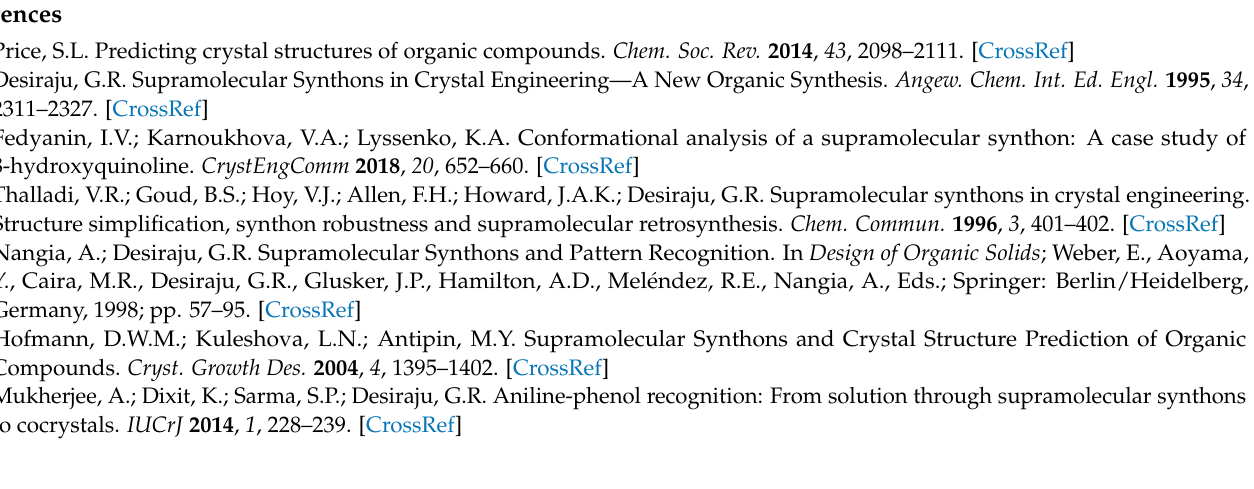
tures, 99.5%) conformations; Figure S2. (a)Propensity-coordination chart of P1 - P6 molecules and (b) coordination of each functional group in all predicted motifs; Figure S3. Propensity-coordination chart of P7 - P8 molecules and the coordination of each functional group in all predicted motifs; Figure S4. Propensity-coordination chart of P9 - P10 molecules and the coordination of each functional group in all predicted motifs; Figure S5. Propensity-coordination chart of P11-P12 molecules and the coordination of each functional group in all predicted motifs; Figure S6. 1 H NMR of 3-acetamido- 1H-pyrazole, P1 ; Figure S7. 1 H NMR of 3-acetamido-5methyl-1H-pyrazole, P2 .; Figure S8. 1 H NMR of 3-propamido-1H-pyrazole, P3 ; Figure S9 . 1 H NMR of 3-propamido-5methyl-1H-pyrazole, P4 ; Figure S10. 1H NMR spectrum of 3-butyramido pyrazole, P5 ; Figure S11. NMR spectrum of 3-butyramido 5-methyl pyrazole, P6 ; Figure S12. 1 H NMR of 3-benzamido-1H-pyrazole, P7 ; Figure S13. 1 H NMR of 3-benzamido-5methyl-1H-pyrazole, P8 ; Figure S14. 1 H NMR of N-(pyrazole- 2-yl)nicotinamide, P9 ; Figure S15. NMR spectrum of N-(5-methylpyrazol-2-yl)nicotinamide, P10 ; Figure S16. NMR spectrum of N-(pyrazole-2-yl)isonicotinamide, P11 ; Figure S17. NMR spectrum of N-(5-methylpyrazol-2-yl)isonicotinamide, P12 ; Table S1. Energies of each trans amide conformation relative to most stable trans conformation is shown below in kJ/mol. The conformations with dupli- cate energies were ignored. Note: methyl-based target molecule conformations are not shown here; Table S2. Hydrogen-bond energies (in kJ/mol) for each individual synthon for molecules P1 - P12 . Synthon A and C are dimeric synthons; therefore, energies are presented for pairs of molecules; Table S3. Hydrogen-bond energies (in kJ/mol) for each combination synthon for molecules P1 - P12 ; Table S4. Functional groups used to determine the hydrogen-bond propensities for the P1-P12 target molecules. The labels in the figures can be explained as follows: Tn = atom makes n bonds, c = atom is cyclic, = bond is acyclic, and Hn = n bonded hydrogen atoms; Table S5. Hydrogen-bond propensities for each individual synthon possible in molecules P1-P12 ; Table S6. Hydrogen-bond propensities for combination synthons possible in molecules P1-P12 . Combination synthon propensi- ties are calculated by multiplying the individual synthon propensities; Table S7. Experimental details of crystals obtained in this